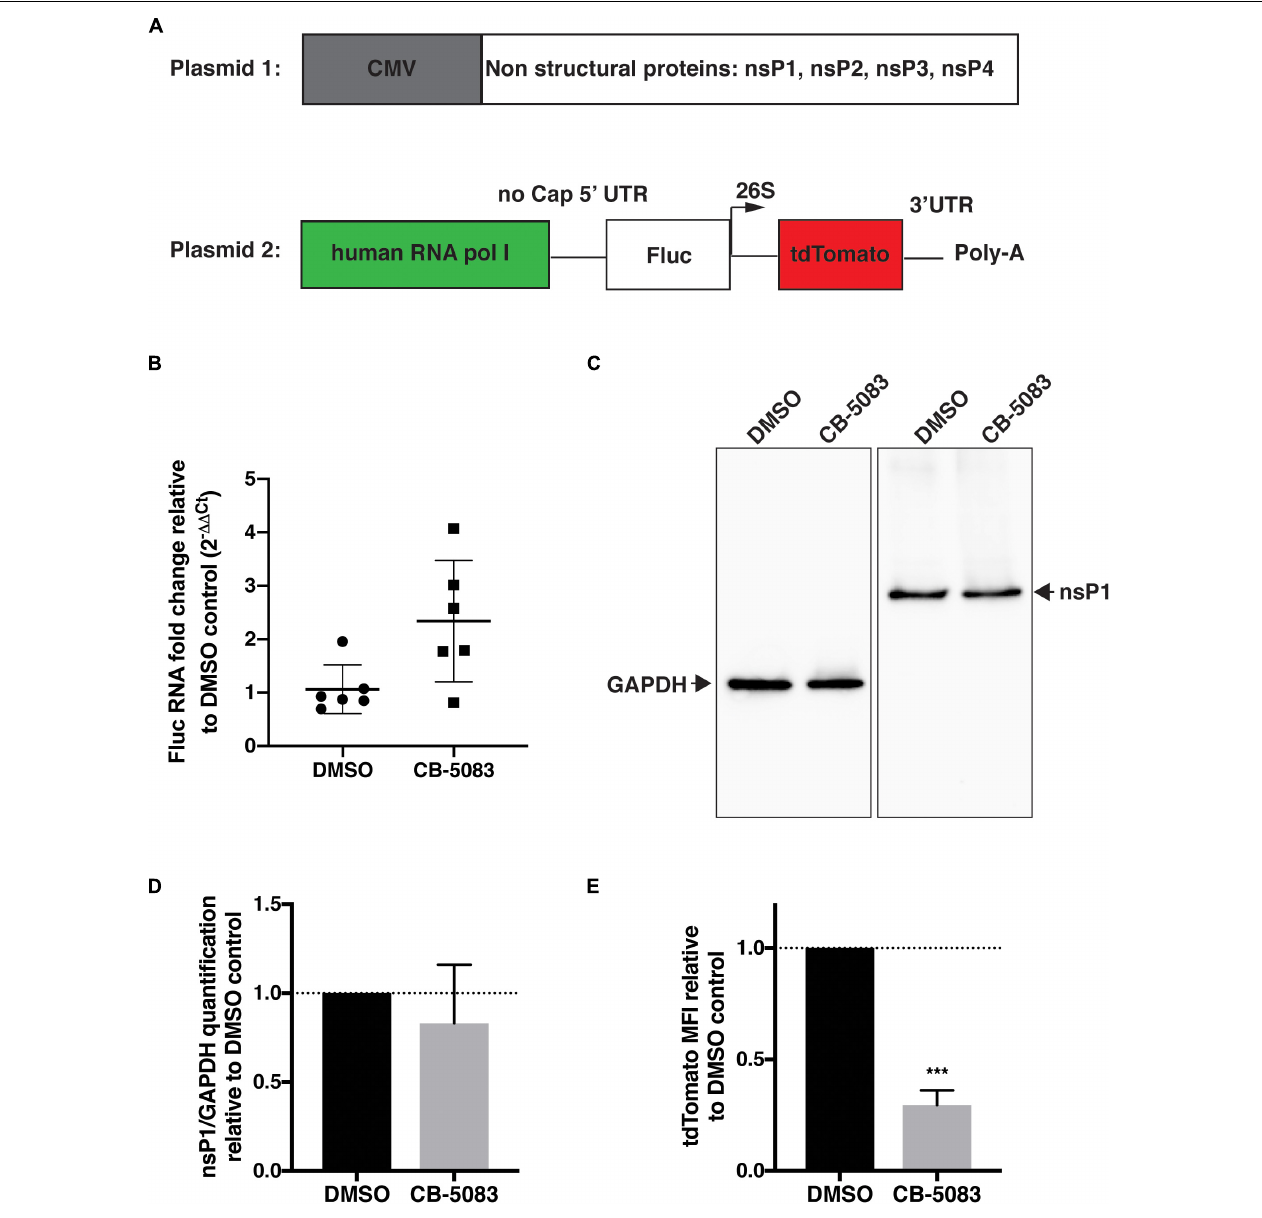
FIGURE 4 | VCP is essential for CHIKV replicase activity. HEK 293T cells were co-transfected with plasmid 2 alone (panel B ) or plasmids 1 and 2 (ratio 2:1, panels C–E ), 5–6 h post transfection, media was refreshed with DMSO control or CB-5083 (1 µ M). 16 h post media refresh, cells were collected and separated for RNA extraction or whole cell lysate and flow cytometry analysis. (A) Schematic representation of the CHIKV trans-replication plasmid system used. (B) Relative Fluc RNA fold change compared to control using 2 − (cid:49)(cid:49) C T method. (C) Representative Western blot of whole cell lysates probed for GAPDH and CHIKV nsP1 proteins, respectively. (D) Relative quantification of nsP1 protein amount versus GAPDH for each experimental replicate. (E) Mean fluorescent intensity (MFI) of tdTomato assessed by flow cytometry in tdTomato positive cells. The data presented are of three independent experiments (two for panel B ) and were analyzed by Mann–Whitney non-parametric two-tailed test; ∗∗∗ p <